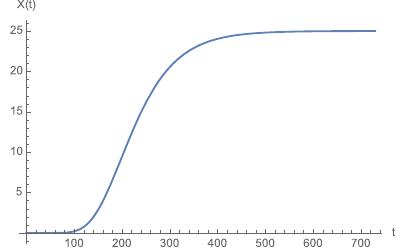
Figure 4. Gompertz curve (22) related to the investigated tumor. The inflection point is (198.477 days, 9.19654 cm 3 ). On the t -axis there is the time in days and on the ordinate axis the tumor volume in cm 3